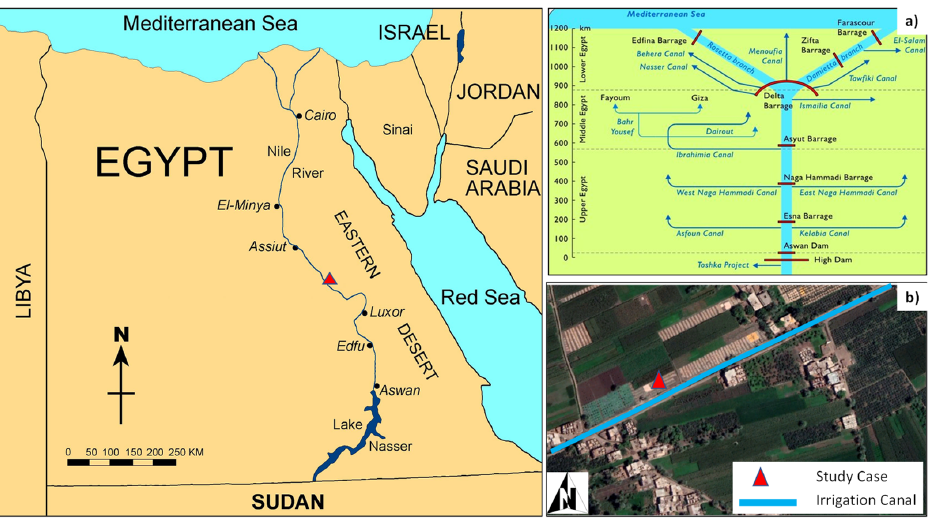
Figure 1. The Nile River flowing through Egyptian territory; ( a ) irrigation system in Egypt adapted after Abdrabbo [46] and ( b ) location of the case study site.